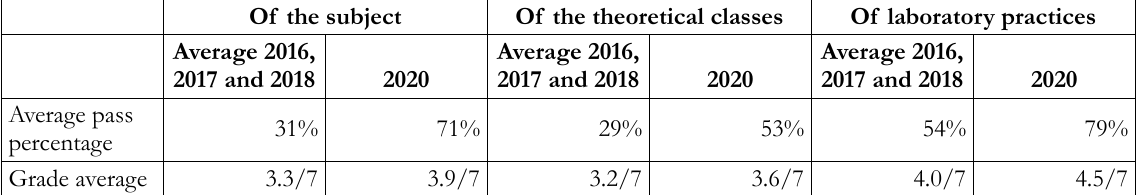
Table 14. Comparative analysis of the results related to the academic performance of the student body in the different academic